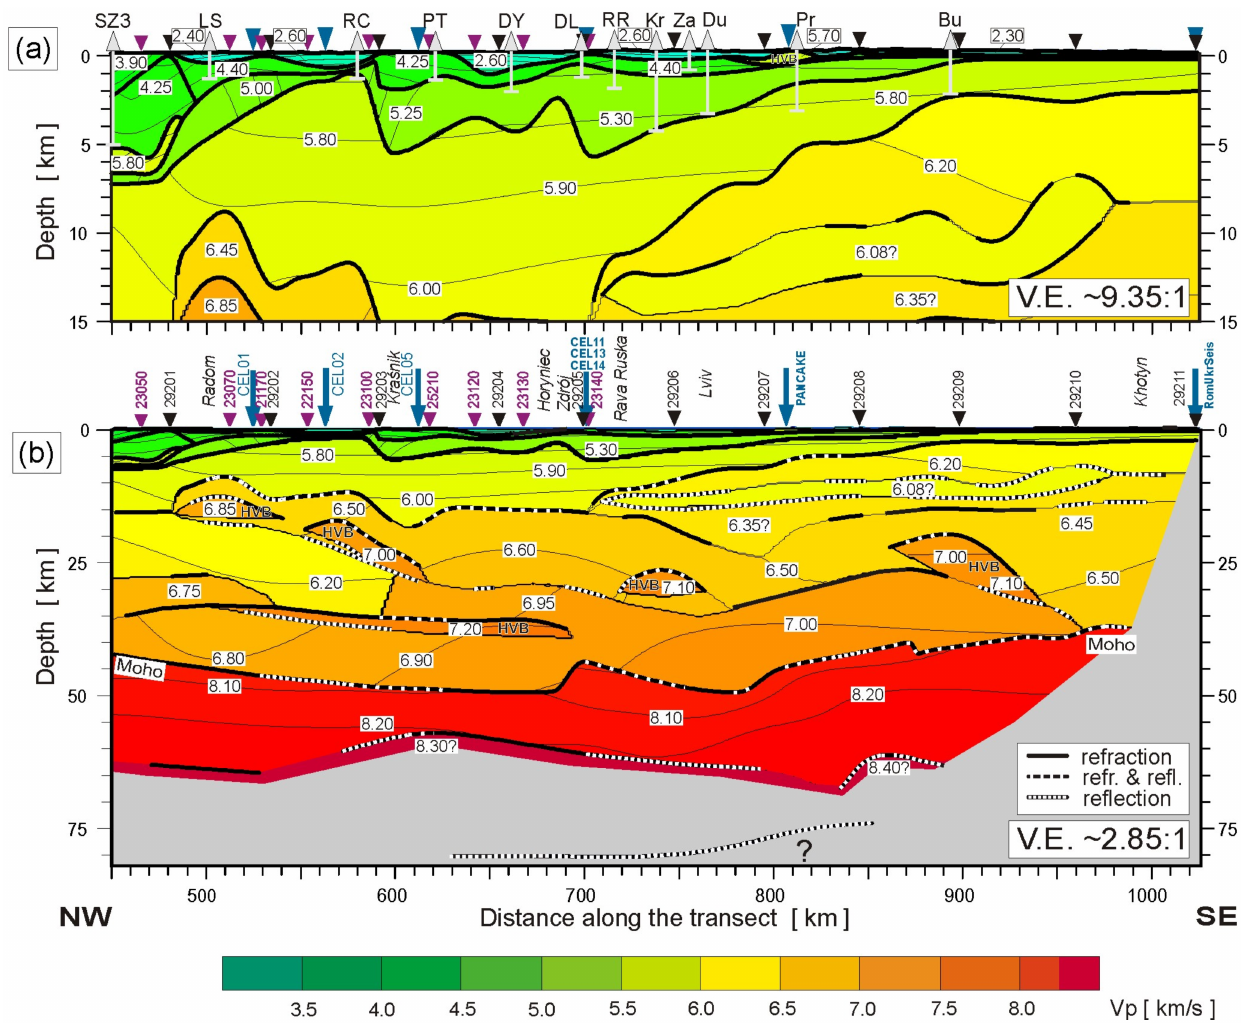
Figure 7. Two-dimensional models of P-wave seismic velocities in the crust and upper mantle ( a , b ) along the TTZ-South and part of CEL03 profiles derived by forward ray-trace modelling using SEIS83 [106]. The initial model was based on information from other geophysical investigations in the region, such as drillholes (marked as bright vertical lines in ( a ): SZ3—Szwejki IG-3 (NE—7 km); LS—Lis ó w 1 (NE—24 km); RC—Rach ó w-1 (SW—3.2 km); PT—Potok IG-1 (NE—4 km); DY—Dyle IG-1 (NE—9 km); DL—Doliny-1 (SW—2.5 km); RR—Rava Ruska 4 (NE—8.4 km); Kr—Krekhiv 1 (NE—16.9 km); Za—Zashkiv 97 (NE—11.2 km); Du—Dublyany 3, no info; Pr—Peremyshlyany 1 (SW—5.5 km); Bu—Buchach 3 (SW—10.6 km)) and shallow reflection profiles. Thick, black solid, and dashed lines represent major velocity discontinuities (boundaries). HVB means a h igh v elocity b ody. Only those parts of the discontinuities that have been constrained by reflected or refracted arrivals of P-waves are shown: solid line—refraction only; dashed line—refraction and reflection; dotted line—reflection only. Thinner lines represent inferred velocity isolines with values in km/s shown in white boxes. The positions of tectonic units at the surface, including the approximate extent of the TTZ along the profile, are indicated. Inverted triangles show positions of shot points. Blue arrows show intersections with other WARR profiles (cf. Figure 1). Wells considered when constructing an initial geological model prior to the velocity modelling are also shown. Vertical exaggeration is ~9.35:1 for the upper part of the model ( a ) and ~2.85:1 for the whole model ( b ). Arrivals from within the crystalline crust include reflected events (PcP), typically at 50–150 km offsets, which are interpreted as reflections from boundaries within the crust, based upon the velocity changes modelled at the discontinuities (SP29204, SP29207). The strongest re- flected arrivals from the crust arise from the PMP phase, the reflection from the Moho